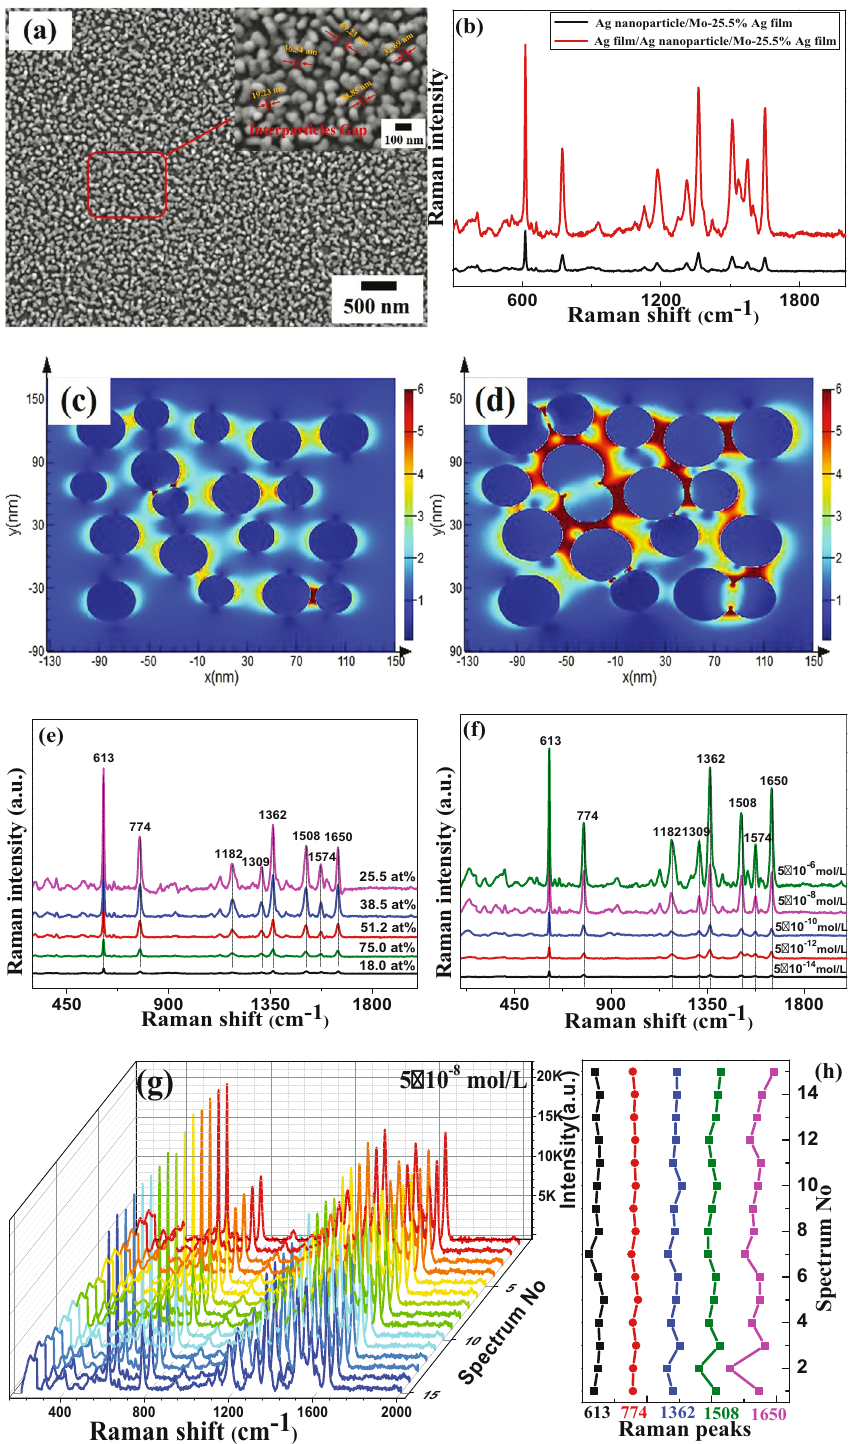
Figure 4: ( a ) Surface morphology of the Ag fi lm/Ag nanoparticles/Mo - 25.5 at% Ag fi lms. ( b ) SERS spectra of the Ag nanoparticles/Mo - 25.5 at% Ag fi lms and Ag fi lm/Ag nanoparticles/Mo - 25.5 at% Ag fi lms. ( c ) FDTD simulations of the EM fi eld intensity of the